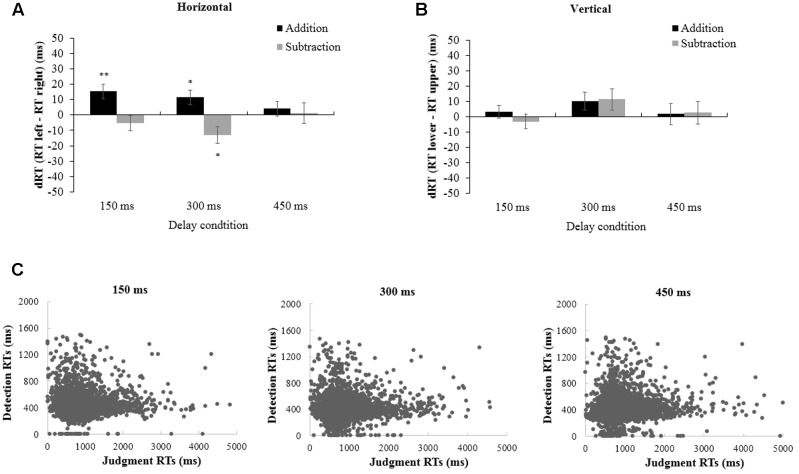
The difference in dRT as a function of operation (addition or subtraction) with 150, 300, and 450 ms delay in horizontal and vertical dimension. (A) dRT = RT (left)–RT (right), “up” means “right faster,” while “down” means “left faster”; (B) dRT = RT (lower)–RT (upper), “up” means “upper faster,” while “down” means “lower faster”; (C) All individual oral latencies (Judgment RTs) against target detection times (Detection RTs) in different delay conditions (150, 300, and 450 ms). Error bars represent standard error of the mean (SEM). ∗p < 0.05, ∗∗p < 0.01. Here and elsewhere, data for the target detection task only are shown (see main text).